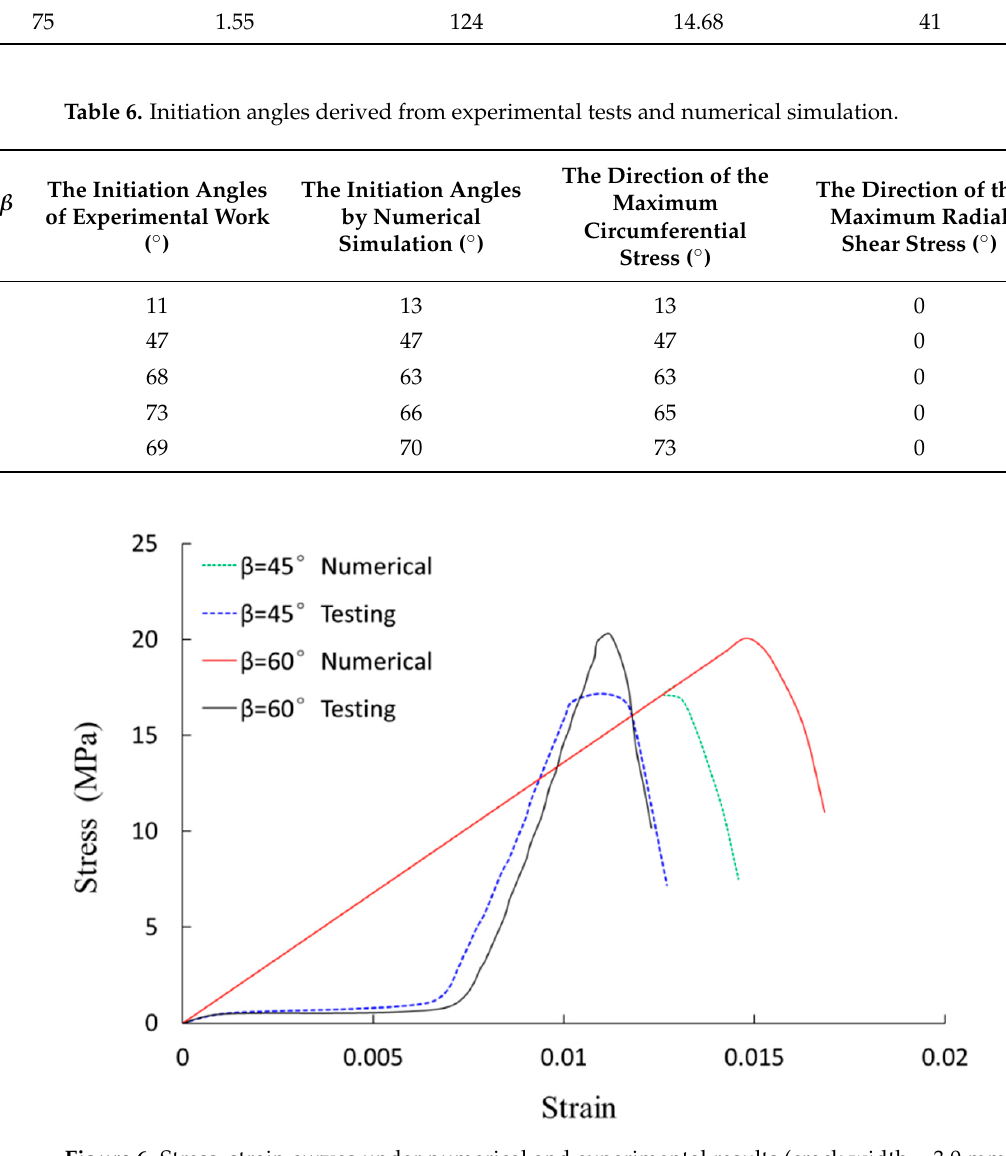
( e ) Figure 7. Fracture propagation numerical simulation of single joint-fissured concrete sample where the single crack thickness is 0.5 mm. ( a ) β = 15°; ( b ) β = 30°; ( c ) β = 45°; ( d ) β = 60°; ( e ) β = 75°.